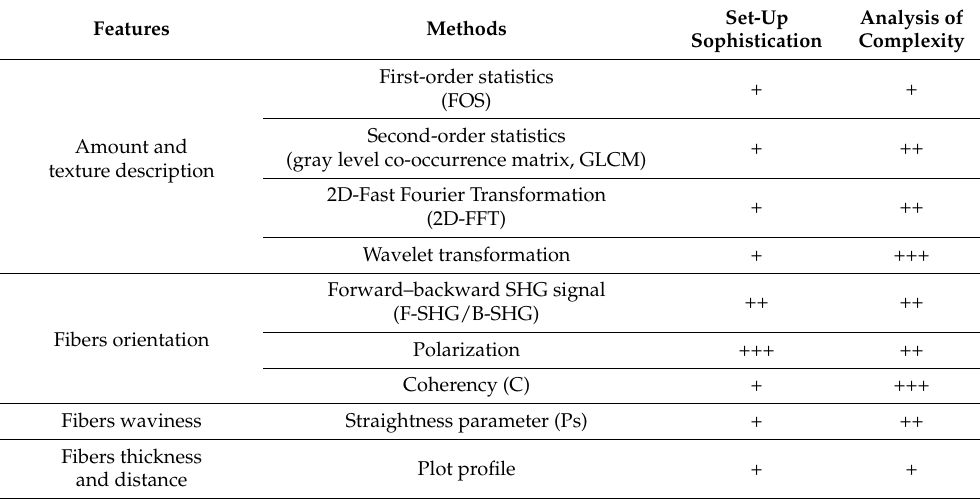
Figure 4. Analysis of SHG images of native and decellularized tissue ( e ) using ImageJ software. ( a ) Coherency analysis showing different values between 0 and 1 with 1 indicating a highly orientated structure. ( b ) Two-dimensional Fast Fourier Transformation (2D-FFT) images indicating a textural feature of the tissue show fibers with the same alignment. ( c ) The straightness parameter Ps quantifies the waviness of fibers and is bounded between 0 and 1. A bundle with Ps = 1 indicates a straight fiber; in contrast, Ps converges to zero when the fibers get very wavy. ( d ) Wavelet transform analysis applies a decomposition of the images ( e ), into four sub-images: low–low (LL), low–high (LH), high–low (HL), and high–high (HH) frequencies. LH, HL, and HH are three high-frequency sub-images that are horizontal, vertical, and oblique, respectively. LL is the low frequency sub-image that contains the main information of the decomposed image. ( f ) Plots profile generation, distances between the peaks can be associated with the distance between the fibers, and similarly, the widths of the peaks may give the thickness of them. Table 2. Features and the approaches employed for image analysis and the corresponding degree of difficulty for the two-photon microscope sophistication and data analysis complexity. + = low difficulty; ++ = medium difficulty; and +++ = high